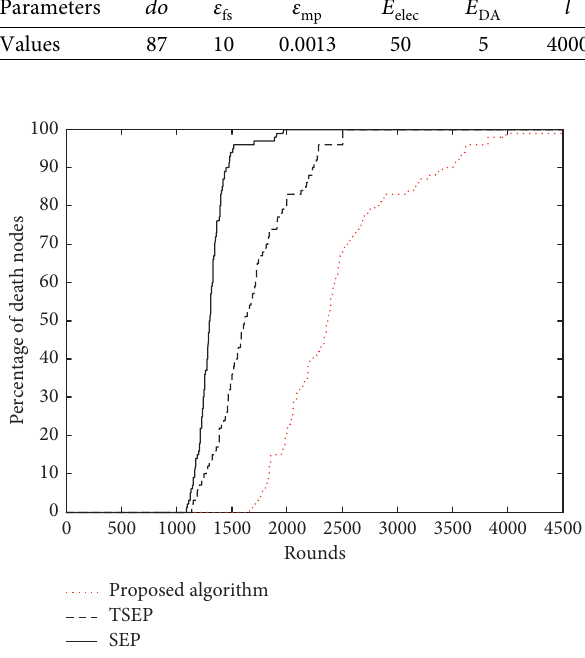
Figure 3: The percentage of death nodes with tree zones.